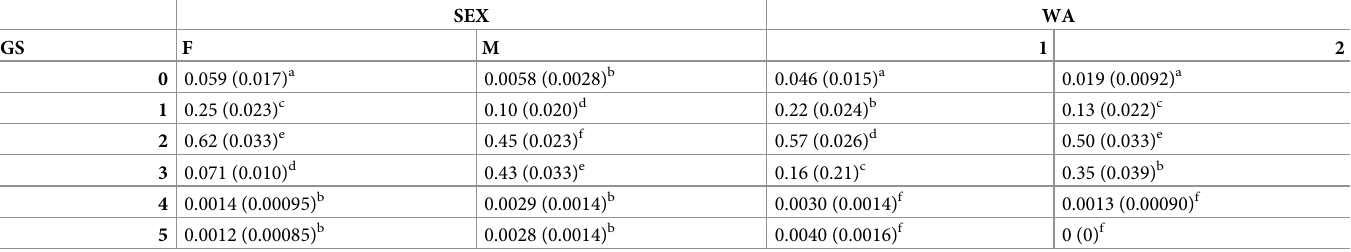
Table 6. The mean proportions (SEM) of birds which had each gait score for sex and welfare assessment. SEX WA GS F M 1 2 0 0.059 (0.017) a 0.0058 (0.0028) b 0.046 (0.015) a 0.019 (0.0092) a 1 0.25 (0.023) c 0.10 (0.020) d 0.22 (0.024) b 0.13 (0.022) c 2 0.62 (0.033) e 0.45 (0.023) f 0.57 (0.026) d 0.50 (0.033) e 3 0.071 (0.010) d 0.43 (0.033) e 4 0.0014 (0.00095) b 5 0.0012 (0.00085) b 0.0028 (0.0014) b 0.0040 (0.0016) f 0 (0) f Different letters denote signicant differences (P <